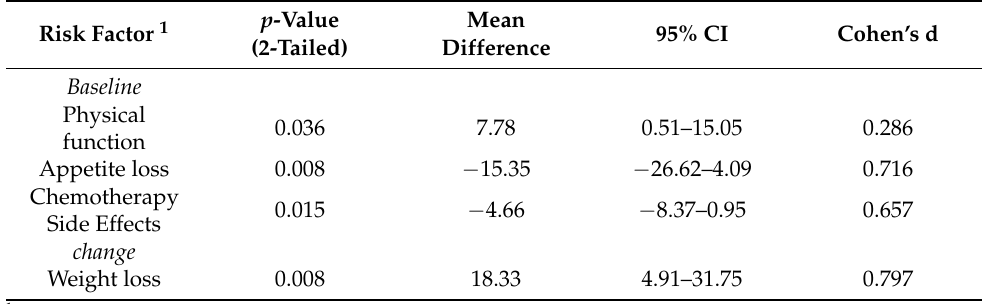
Table 2. M0 compared to M1 for quality of life baseline and change scores using the t -test.